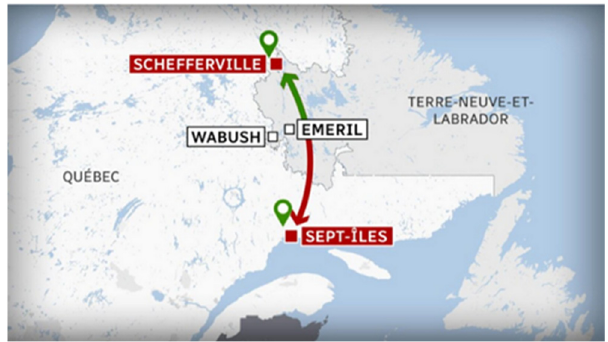
Figure 20. Illustration of Tshieutin company railway in northern Quebec.